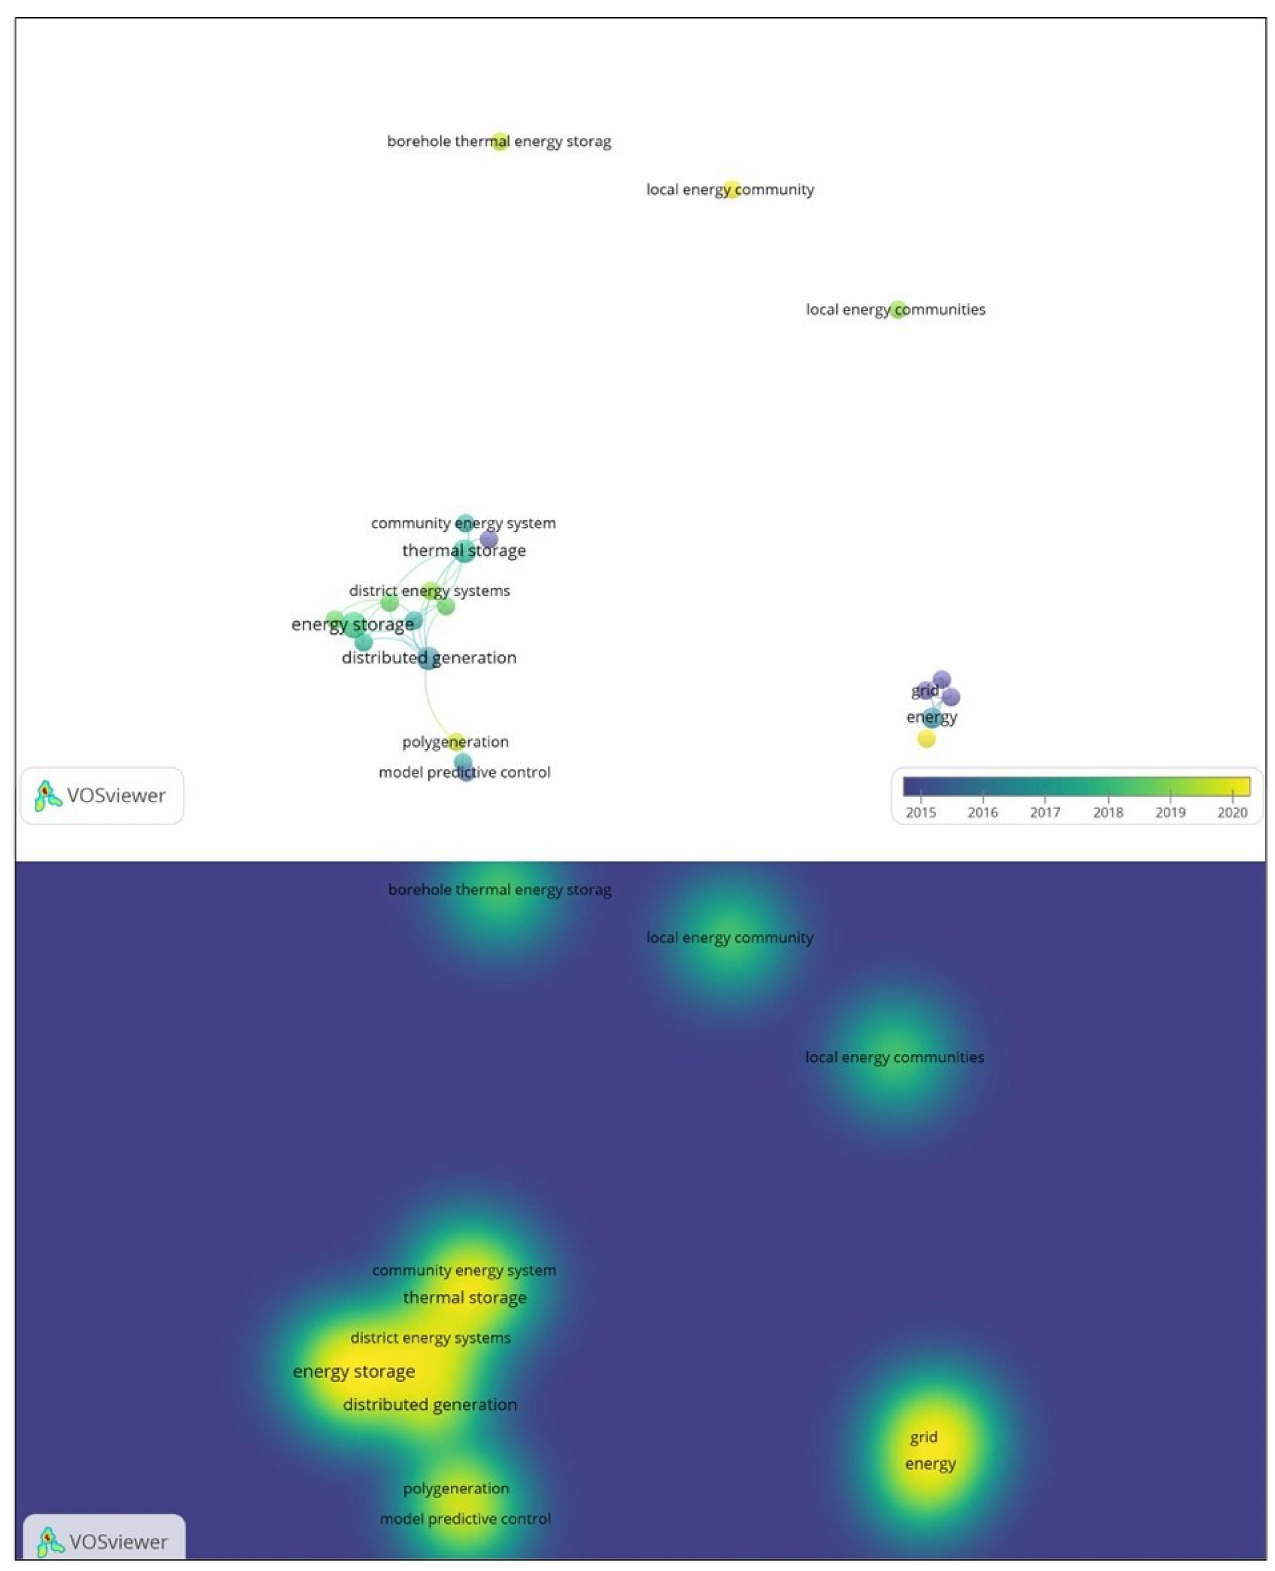
Figure 6. VVS output, overlay and density maps, visualizing the main keywords appearing in the bibliography in the context of LEC and thermal/cooling